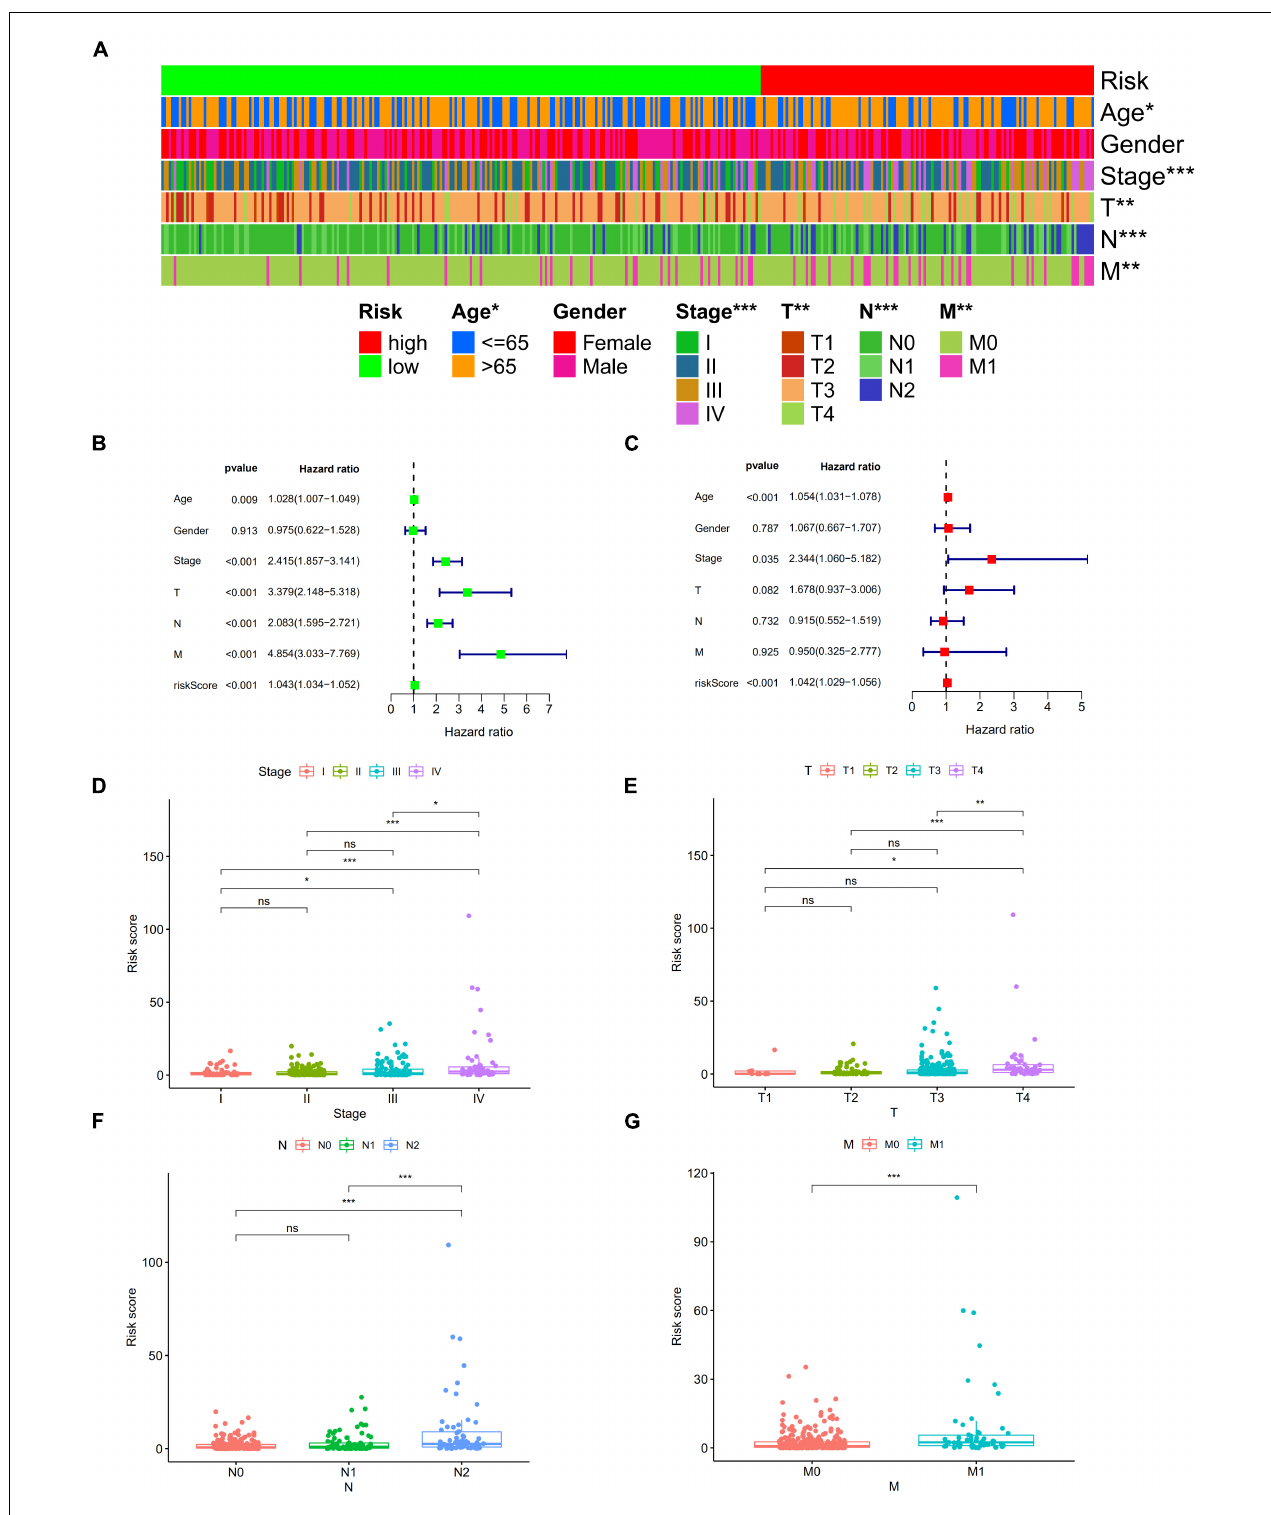
FIGURE 6 | Strip chart (A) showed that age, clinical stage, tumor infiltration depth, lymph node metastasis, and distant metastasis were significantly associated with the risk score. Forest plots of univariate (B) and multivariate (C) Cox regression analyses in colon cancer. Scatters diagram also showed that (D) clinical stage, (E) tumor infiltration depth, (F) lymph node metastasis, and (G) distant metastasis status significantly correlated with the risk score. * p < 0.05; ** p < 0.01; and *** p < 0.001.